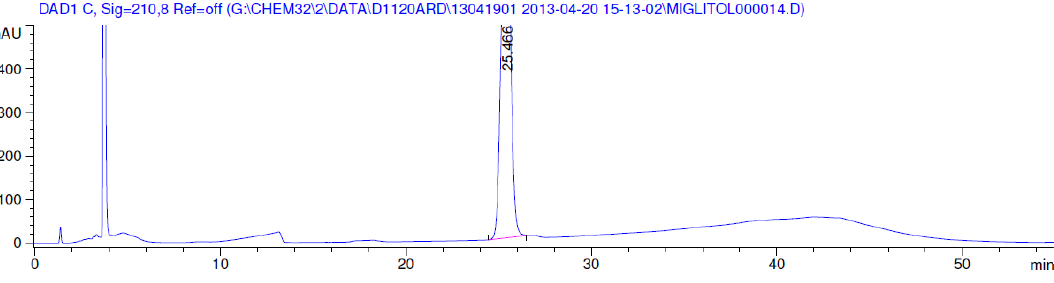
Figure 5. Chromatogram in base degradation.